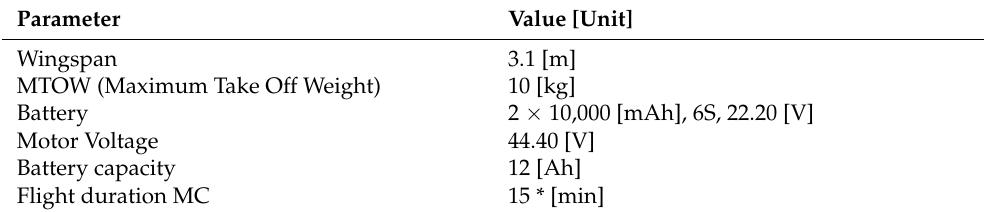
Table 1. Main VTOL